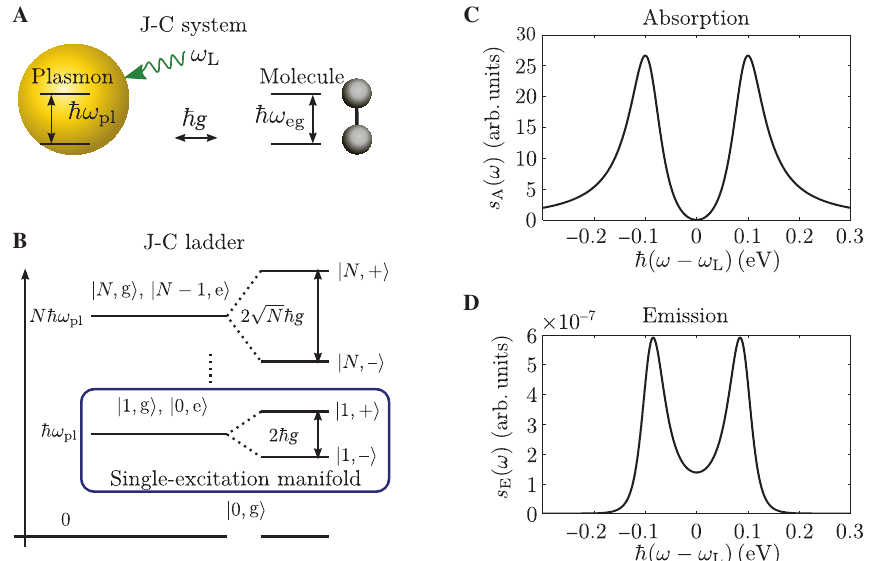
Figure 1: Strong coupling between a plasmonic system and an electronic transition of a molecule, in the absence of molecular vibrations. (A) Schematic depiction of the possible realisation of the Jaynes–Cummings (J-C) model. A dye molecule with an excitonic transition of energy ħ ω is placed near a metallic cavity that sustains a plasmonic mode at energy ħ ω . Both systems are tuned to the resonant eg pl = ω condition ω . The plasmonic cavity is illuminated by a single pump laser of frequency, ω , or by a combination of a pump and a probe eg pl L laser. (B) J-C ladder showing the coherent mixing of the electronic levels of the molecule with the bosonic levels of the plasmon (defined by states | N , g(e)⟩ in the noninteracting case) into a set of hybrid states | N , ± ⟩ under the strong-coupling conditions. The blue frame marks the single-excitation manifold determining the system response under weak-illumination conditions. (C) Absorption spectrum of a weakly = ω perturbing probe for pumping amplitude ħ ℰ = 1 meV. The pump laser frequency is fixed to ω ( Δ = 0), and we change the frequency of the L pl = ω probe laser. (D) Emission spectrum of the J-C system for zero detuning of the laser ω ( Δ = 0) and pumping amplitude ħ ℰ = 1 meV. The L pl = 2 × 10 − 5 eV, ħ γ = 150 meV, ħ g = 100 meV, ħ ω = ħ ω = ħ ω = 2 model for the following values of the parameters: ħ γ σ a pl eg L